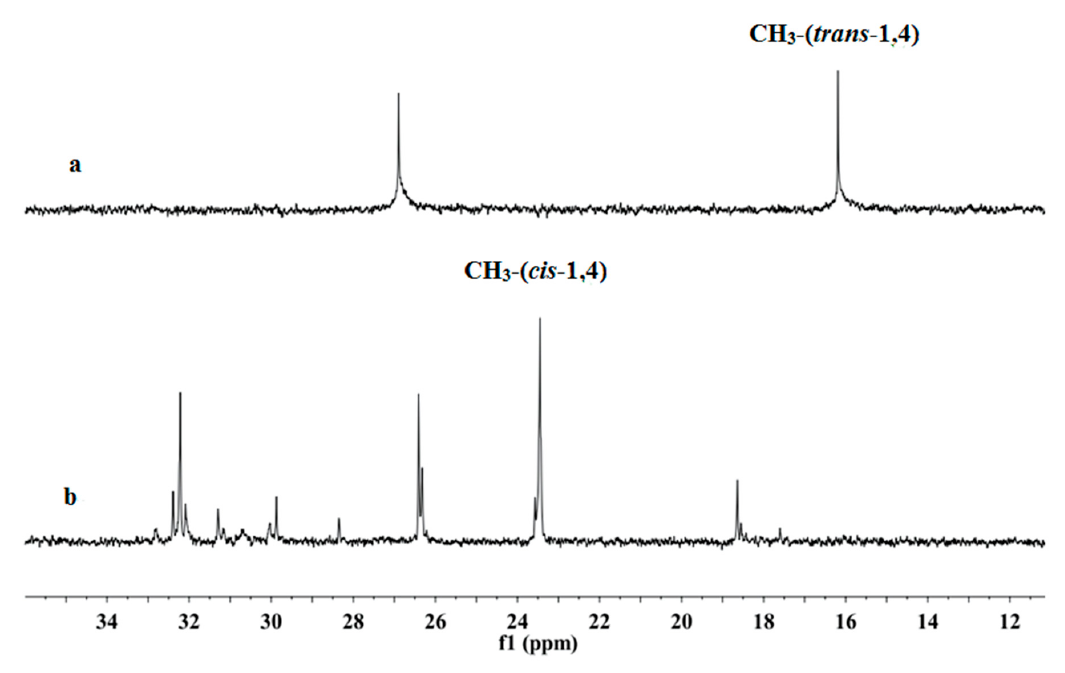
Figure 3. 13 C NMR spectra of polyisoprene obtained by VCl 3 / MAO ( a : Table 1, entry 3) and V3 / MAO ( b : Table 2, entry